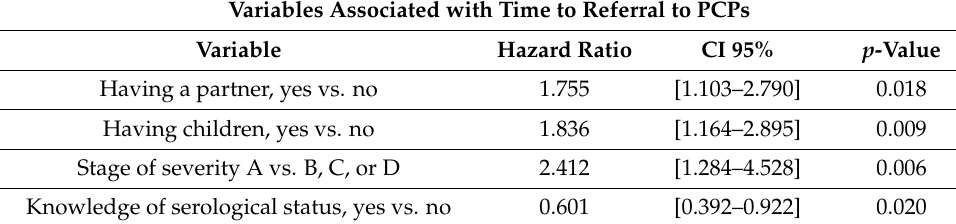
Table 3. Variables associated with the time to referral to primary care.